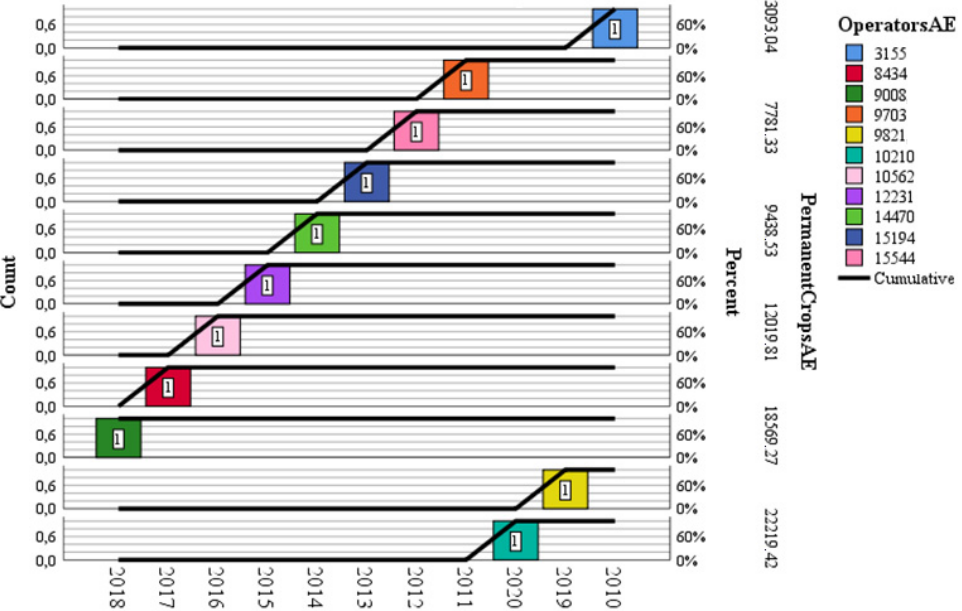
Figure 5. Pareto diagram of the evolution of the dependent variable OperatorsAE in relation to the variable PermanentCropsAE. Source: Elaborated by the authors.